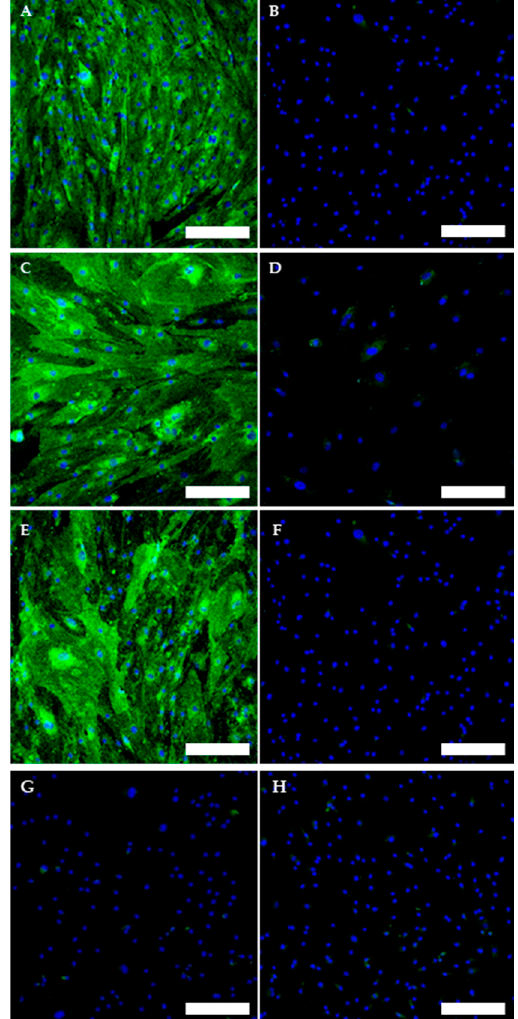
Figure 7. Immunofluorescence staining of Mesenchymal Stem Cell (MSC) and of Hematopoietic surface markers. Immunofluorescence staining of CD44 ( A ), CD105 ( C ), CD90 ( E ) and of CD45 (G) of the TOS1-CSC cell line. Respectively, CD44 ( B ), CD105 ( D ), CD90 ( F ) and of CD45 ( H ) in a human fibroblast cell line (negative control). LSCM in conventional colors: green for MSC markers and blue for nuclei. Original magnification: 10×. Bar size: 100 µm.